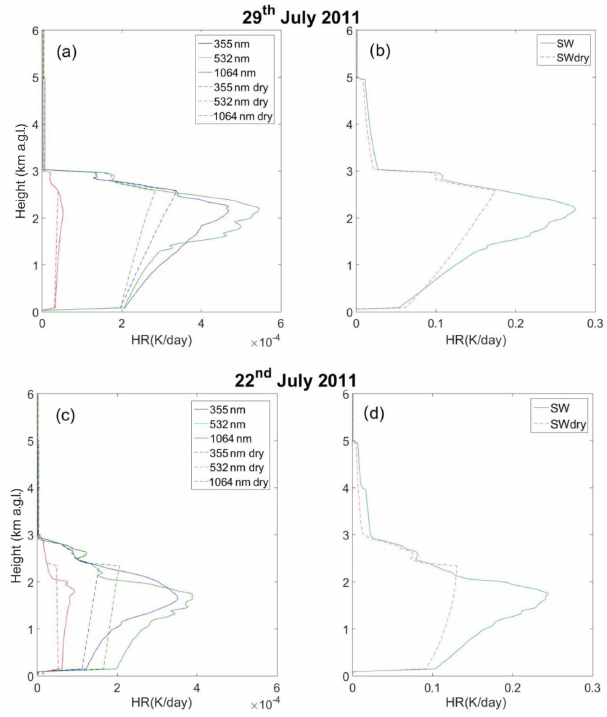
Figure 18. Vertical profiles of aerosol heating rates from the li- dar measurements affected by aerosol hygroscopic growth. Data are presented for the measured lidar measurements (355, 532 and 1054nm) and integrated for the shortwave range